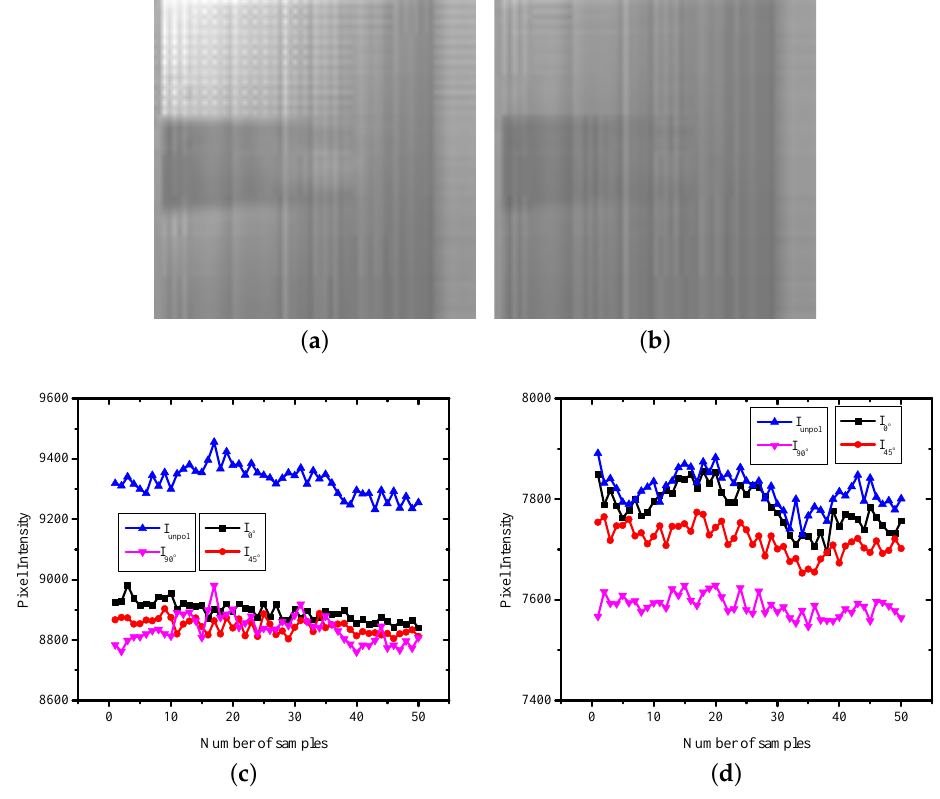
Figure 6. Sample images captured and the intensity variation of the pixels with varying transmission axes over time in an excited state, with incident light being ( a , c ) unpolarized or ( b , d ) linearly polarized at 45 ◦